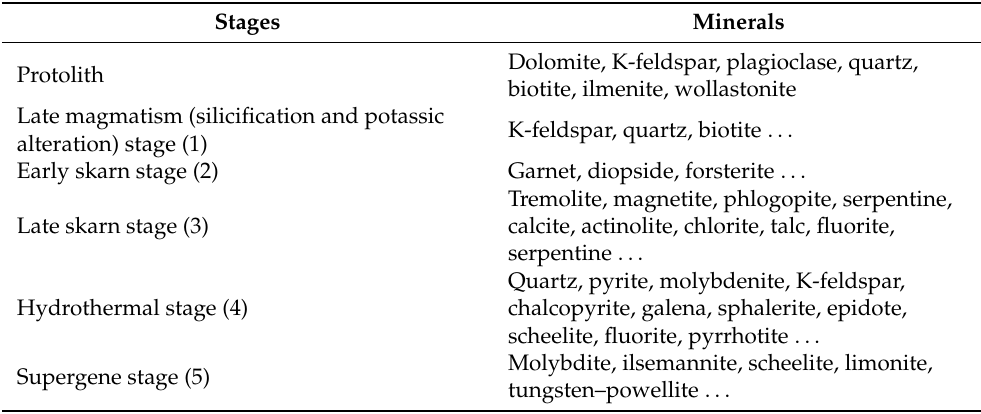
Table 1. Stages of mineralization and paragenesis for the Shangfanggou Mo-Fe deposit. Stages